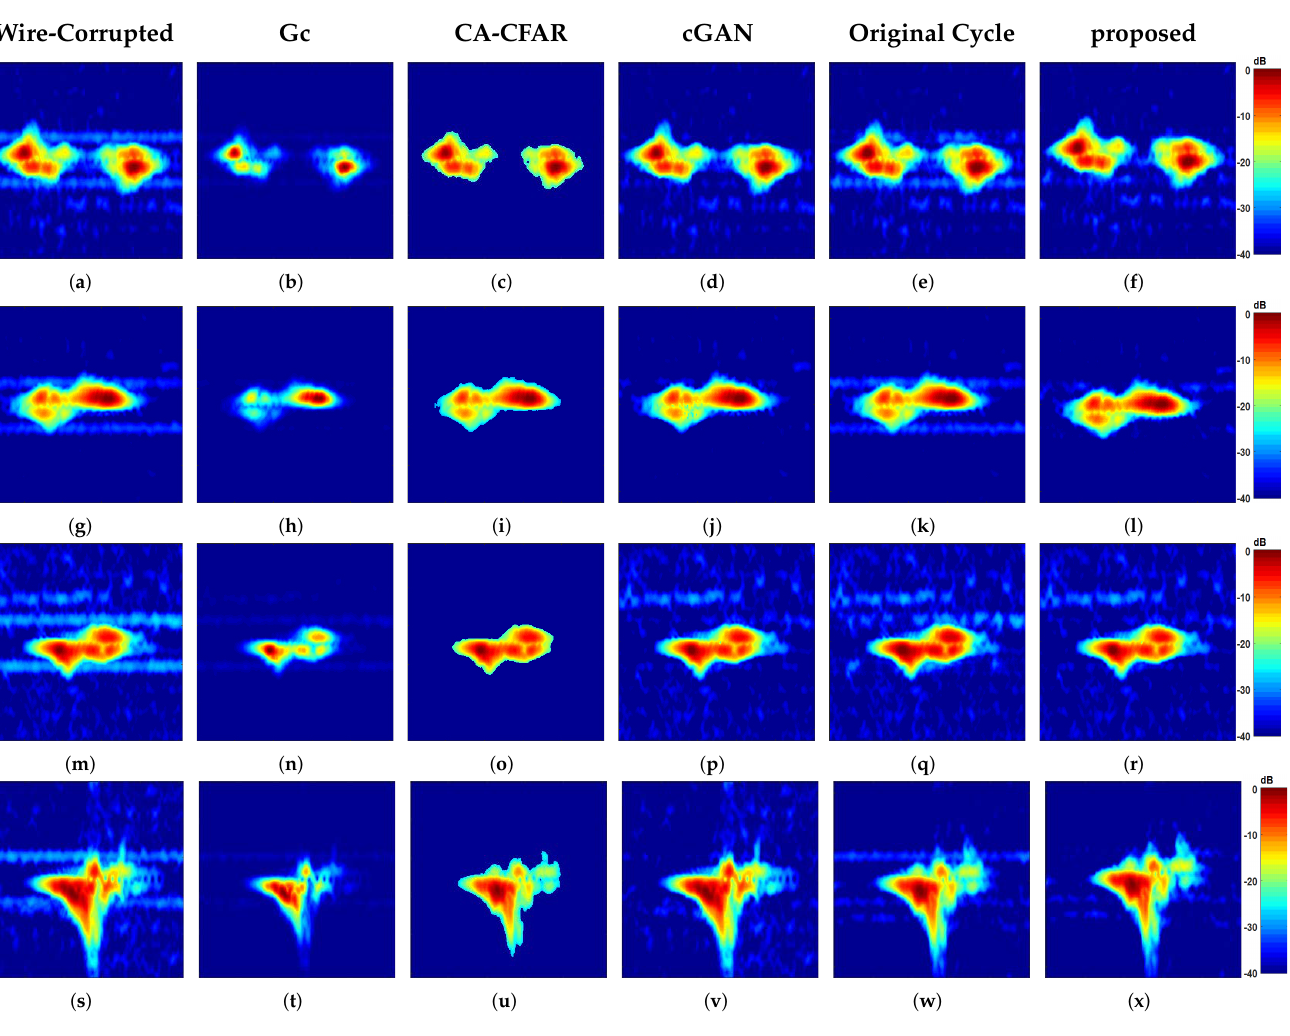
Figure 6. Comparison of through-the-wall various human motion spectrograms using different de-wiring methods (with dynamic ranges set from − 40 dB to 0 dB), ( a – f ) fetching down and up, ( g – l ) sitting down, ( m – r ) standing up, and ( s – x ) falling backward. The titles on the top indicate different de-wiring methods corresponding to the results column by